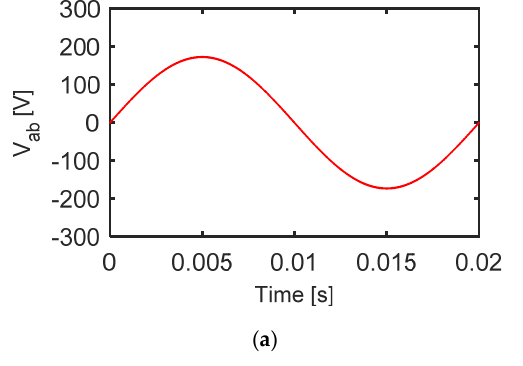
Figure 7. Simulation testing of the clamping circuit at start-up without operating the PWM of the rectifier and charging using line voltage V ab ( a ) Line-input voltage V ab , ( b ) DC-link voltage and ( c ) input current for MC.